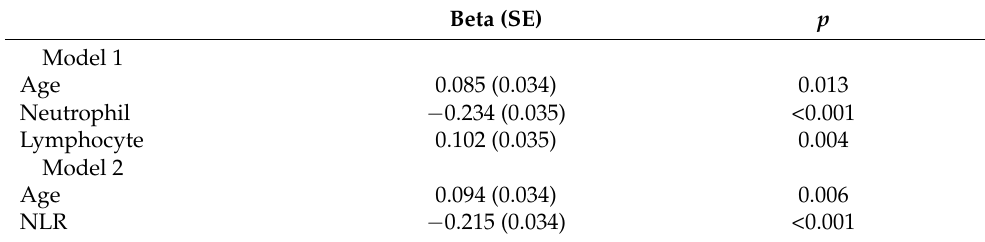
Figure 2. The linear trend lines of neutrophil, lymphocyte counts and their ratio following IFN- γ levels. The trend lines were drawn using linear regression analyses. Table 2. Factors that influence natural killer cell activity in the whole subjects at baseline derived from the linear regression analyses.